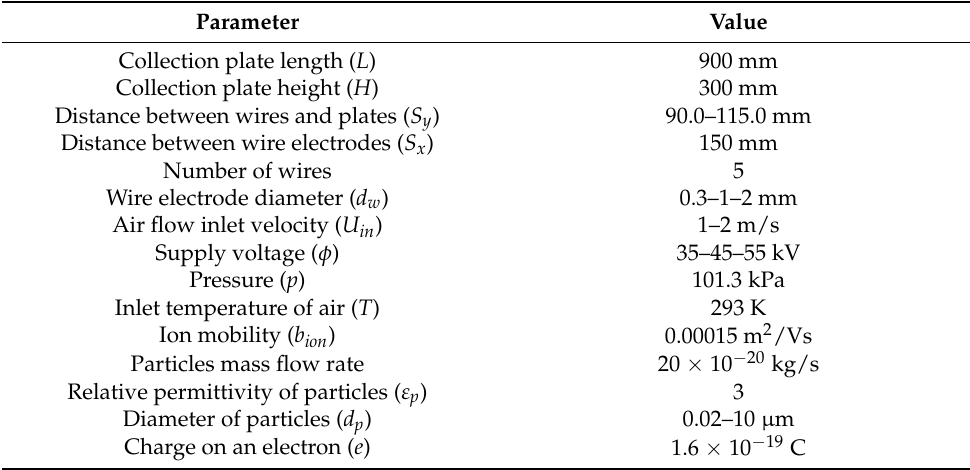
Table 2. Geometric dimensions and operating parameters of the modelled